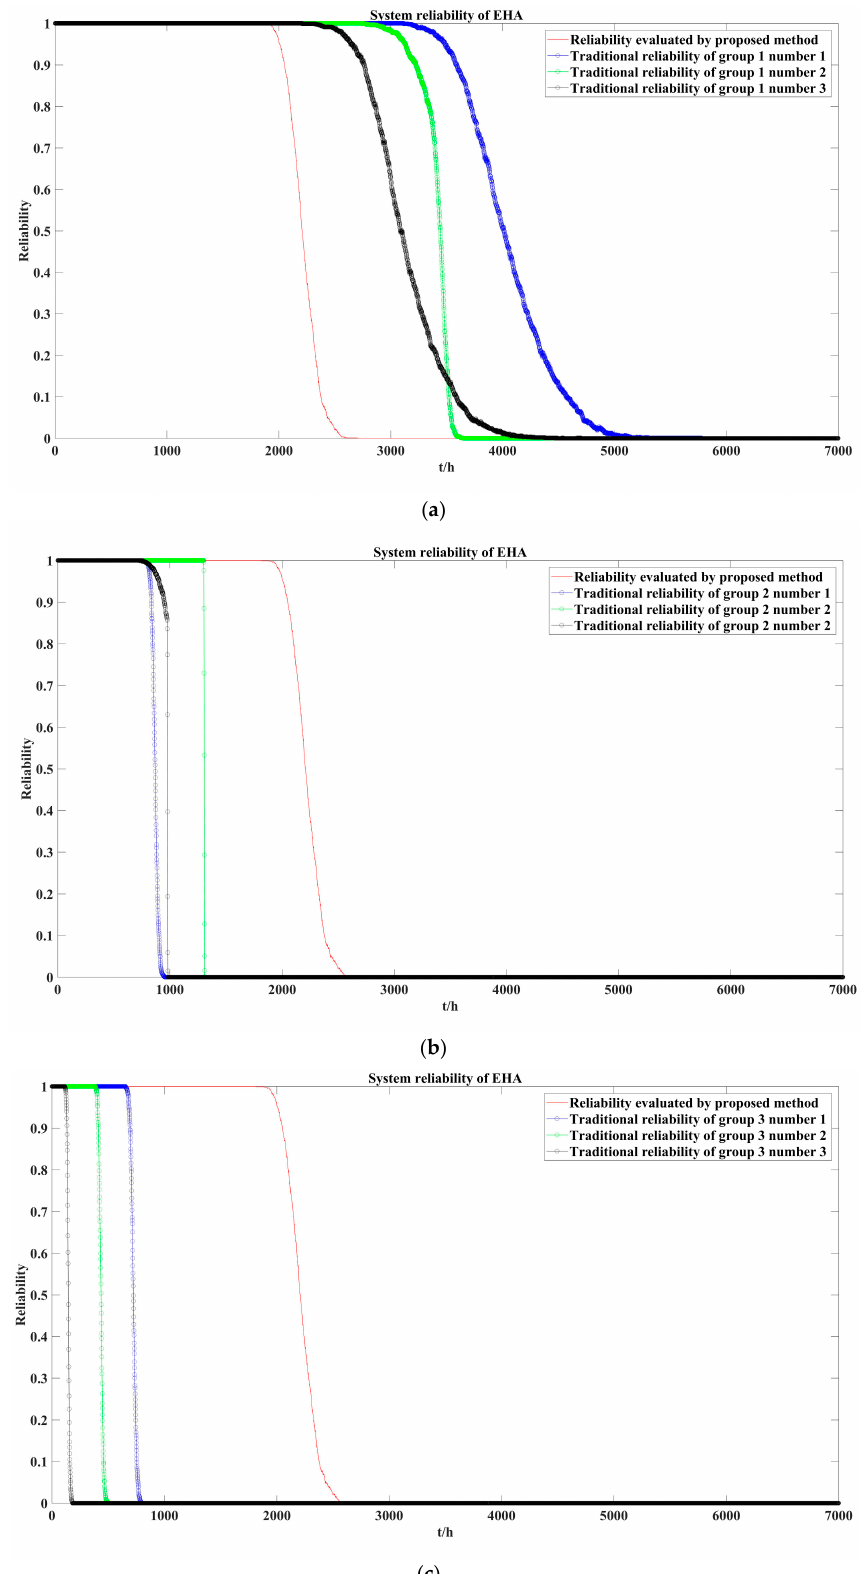
Figure 10. Reliability of electro-hydrostatic actuation system (EHA): ( a ) simulation result of group 1; ( b ) simulation result of group 2; ( c ) simulation result of group 3.